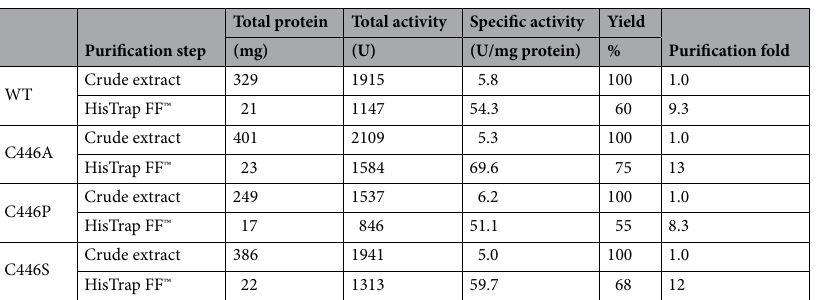
Table 1. Purification table of WT and C446 mutated Sa AMs. Crude extract was prepared from 1.2 L of cell cultures (6.98 g cell wet weight).